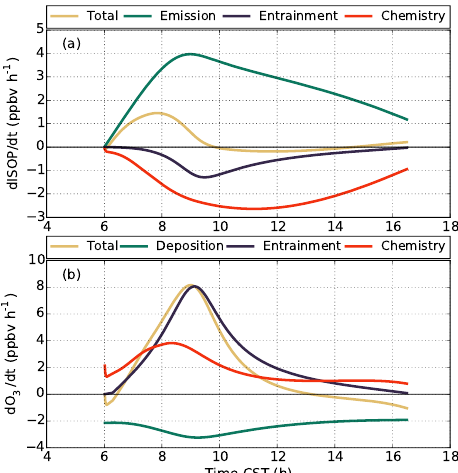
Figure 6. Contribution of dynamics and chemistry to the budgets of (a) isoprene and (b)